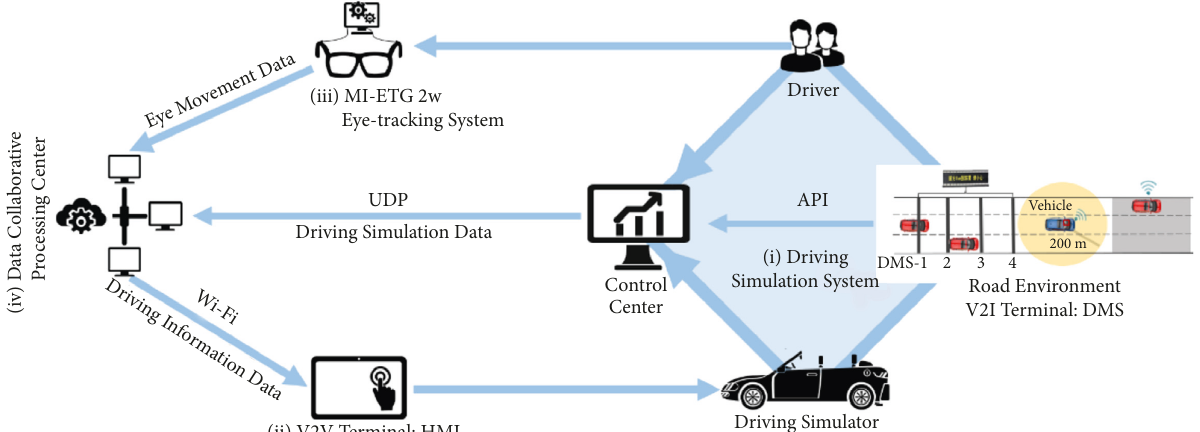
Figure 1: System structure of connected vehicle technology test platform.